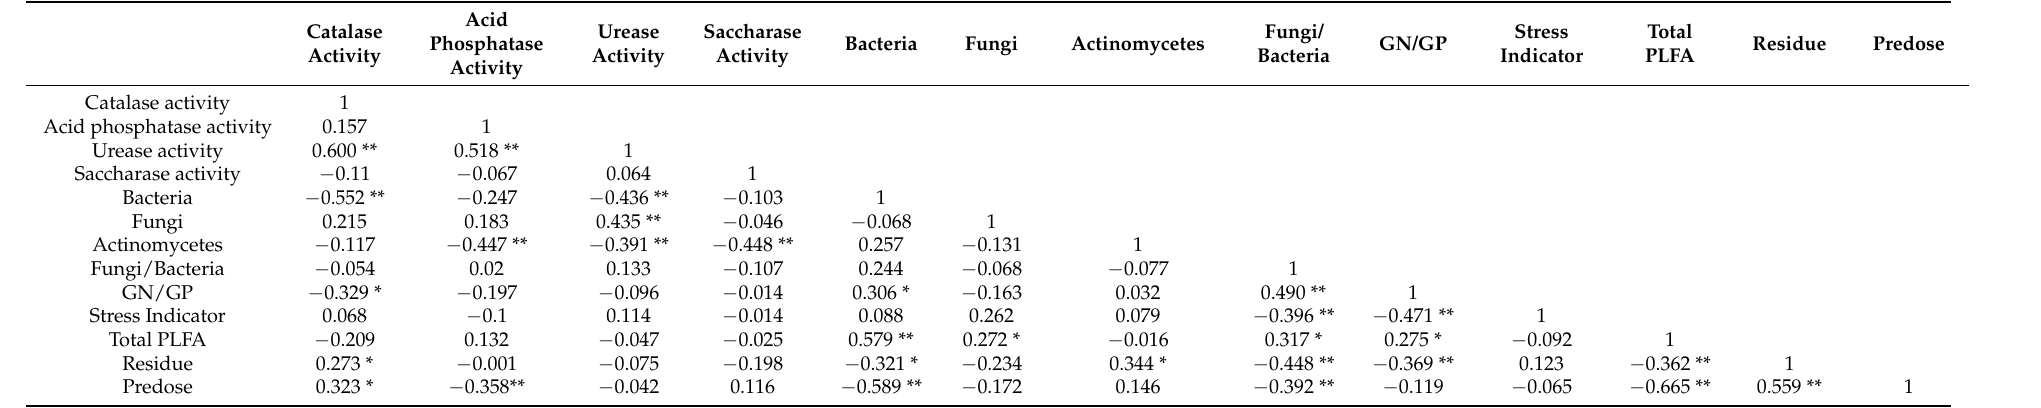
Table 2. Pearson coefficients of correlation between soil PLFA index and environmental